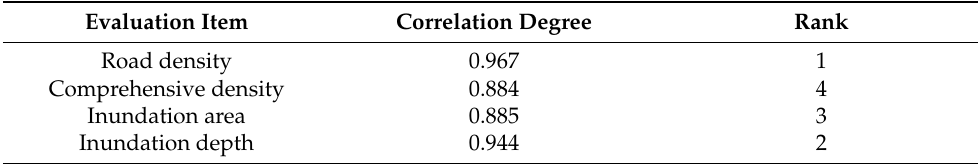
Table 3. Correlation result after eliminating some